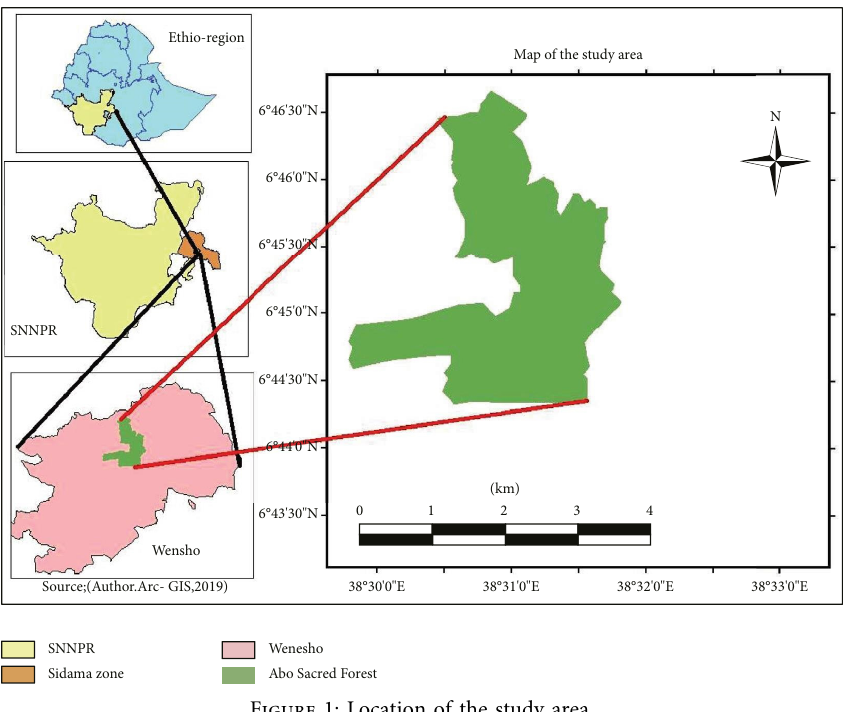
Figure 1: Location of the study